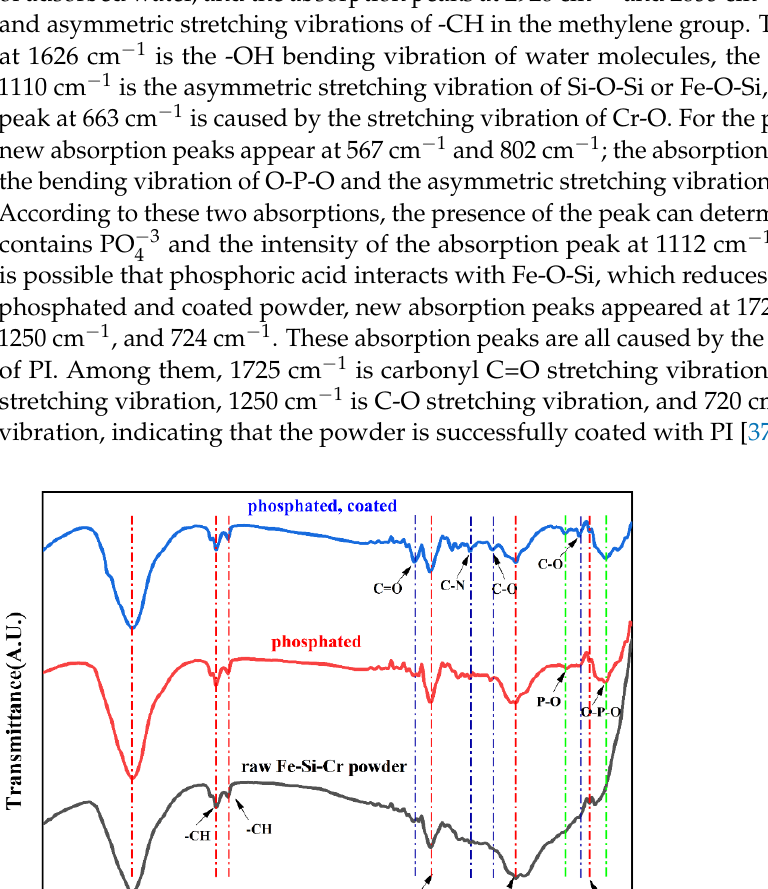
Figure 7. FTIR spectrum of uncoated and coated Fe-Si-Cr powder (from bottom to top is the raw powder, phosphated powder, and phosphate-coated powder.